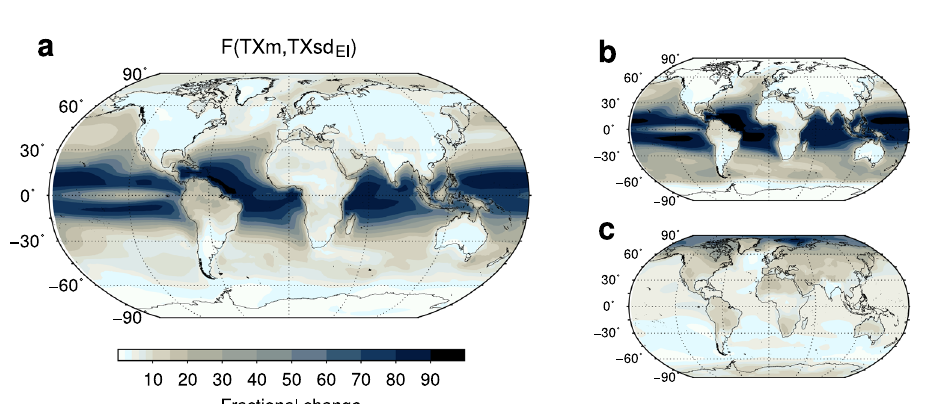
Fig. 6 | Global changes in hot event probabilities and their key determinants. a , b Evolutionofmultimodelglobalandlandaveragedprobabilities(onalog-scale) ofhotandveryhotdaysrespectively(exceedanceprobabilities EP ),asafunctionof changes in global-mean surface air temperature (GSAT) under alternative forcing scenarios. Gray dots denote the total spread in model projections. c Multimodel patternofchangeofhotdayprobabilitiesat+2Kwarming(inthehigh-endscenario